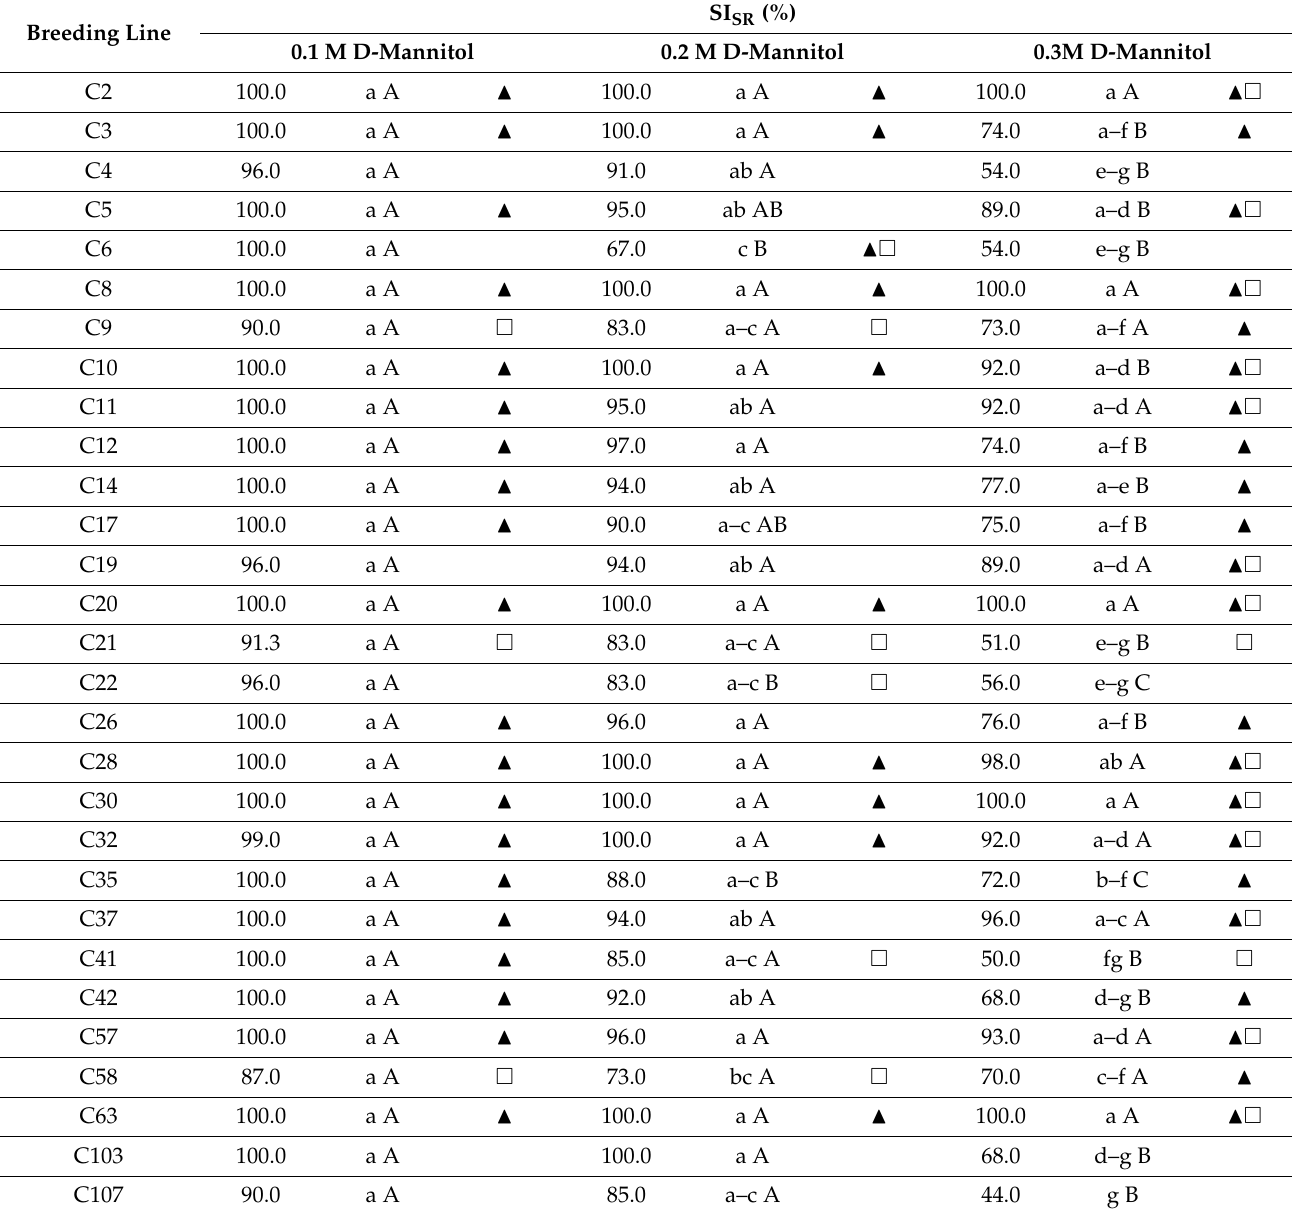
Symbols mark significant differences from the C107 referent line ( (cid:78) ), or from the C103 referent line ( (cid:3) ) according to LSD test; the small letters indicate significantly different means between the breeding lines within a treatment, and the capital letters indicate significantly different means between treatment levels within a breeding line according to Tukey-B